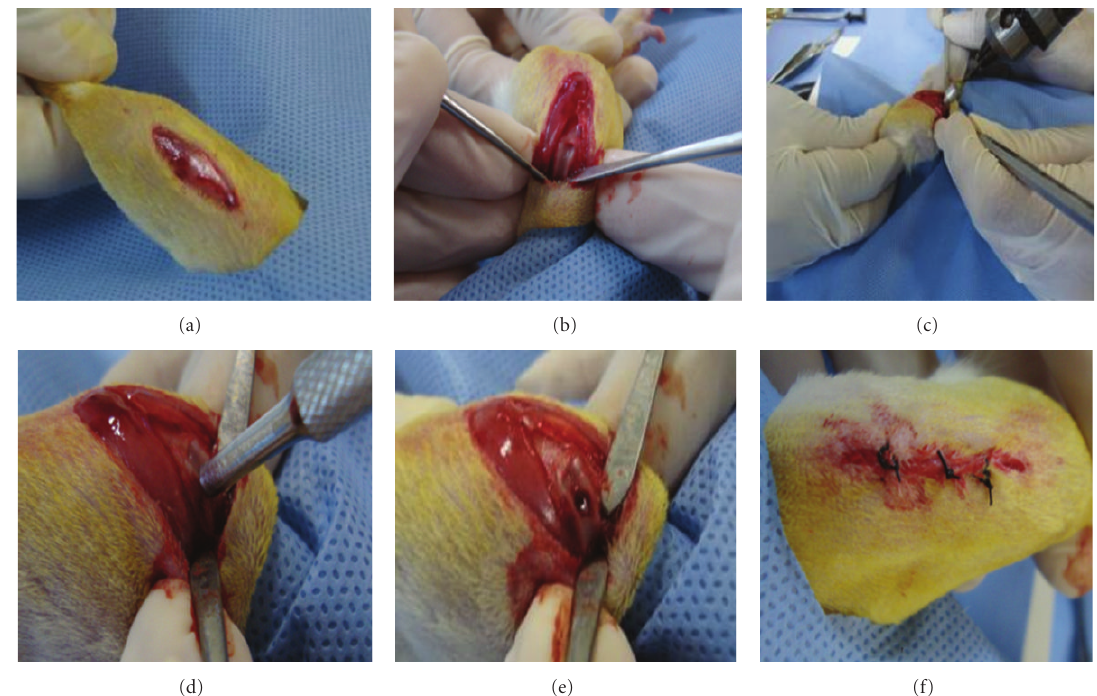
Figure 3: Surgical procedure: (a) skin incision; (b) exposure of the intercondylar region; (c) drilling the osteochondral defect with a 2mm diameter and 1mm depth stop; (d) PVA implant; (e) defect filled with the PVA implant; (f) suture.